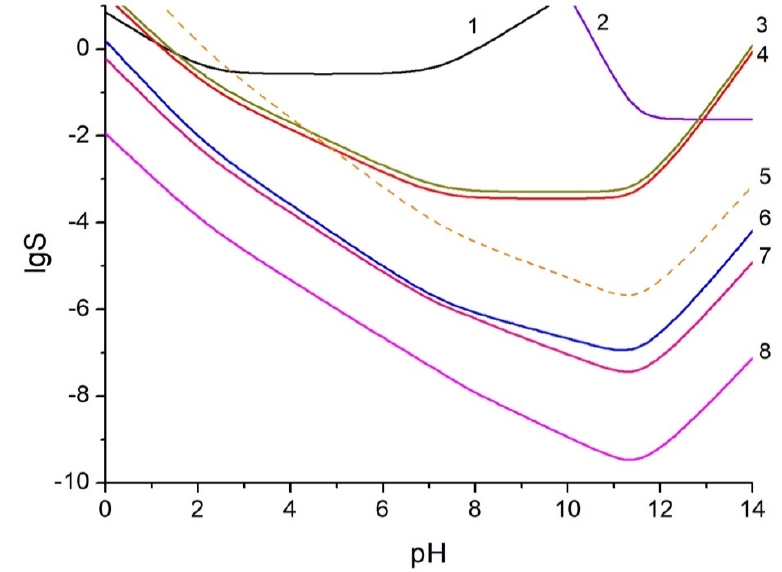
Figure 6. The precipitates solubility isotherms regarding Ca(H 2 PO 4 ) 2. H 2 O (1); Ca(OH) 2 (2); CaHPO 4. 2H 2 O (3); CaHPO 4 (4);  -Ca 3 (PO 4 ) 2 (5); Ca 8 (HPO 4 ) 2 (PO 4 ) 4. 5H 2 O (6);